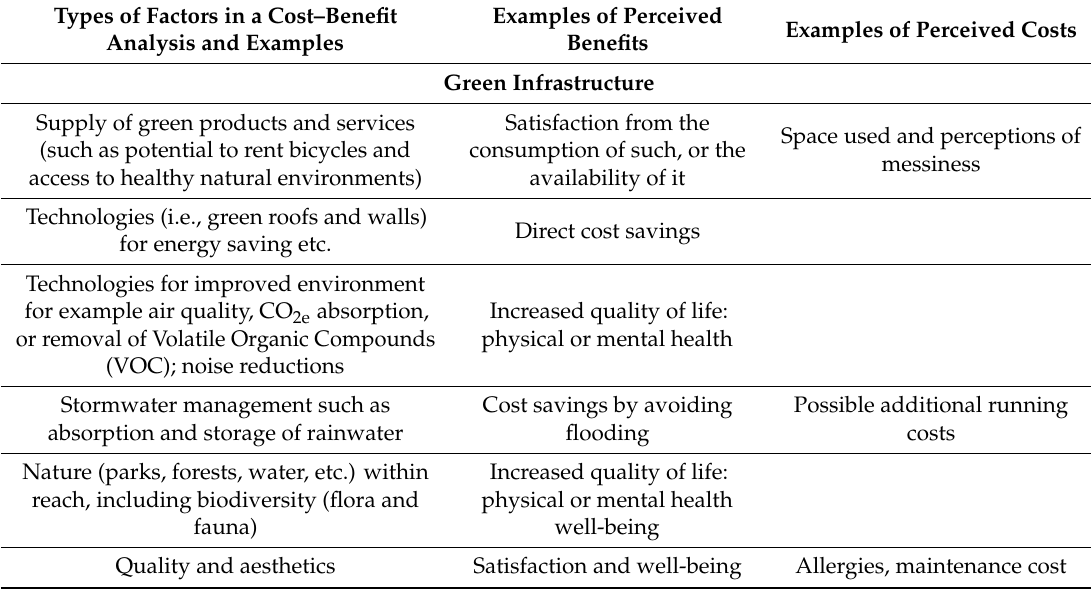
Table 1. Types of costs and benefits to be considered in a cost–benefit analysis